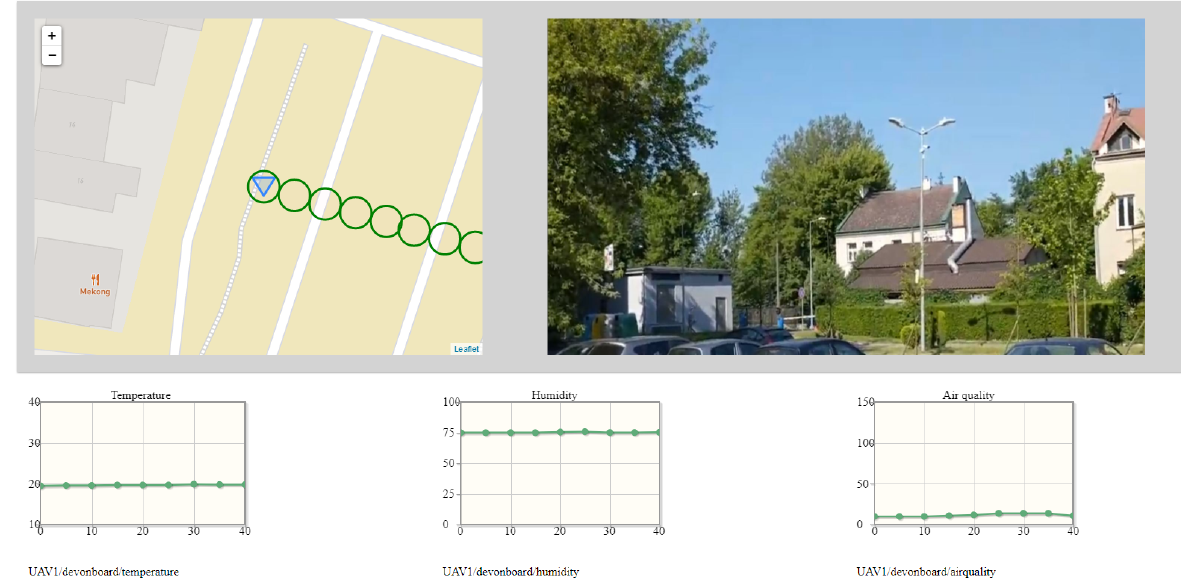
Figure 8. The dashboard, fragments of which were used to prepare Figure